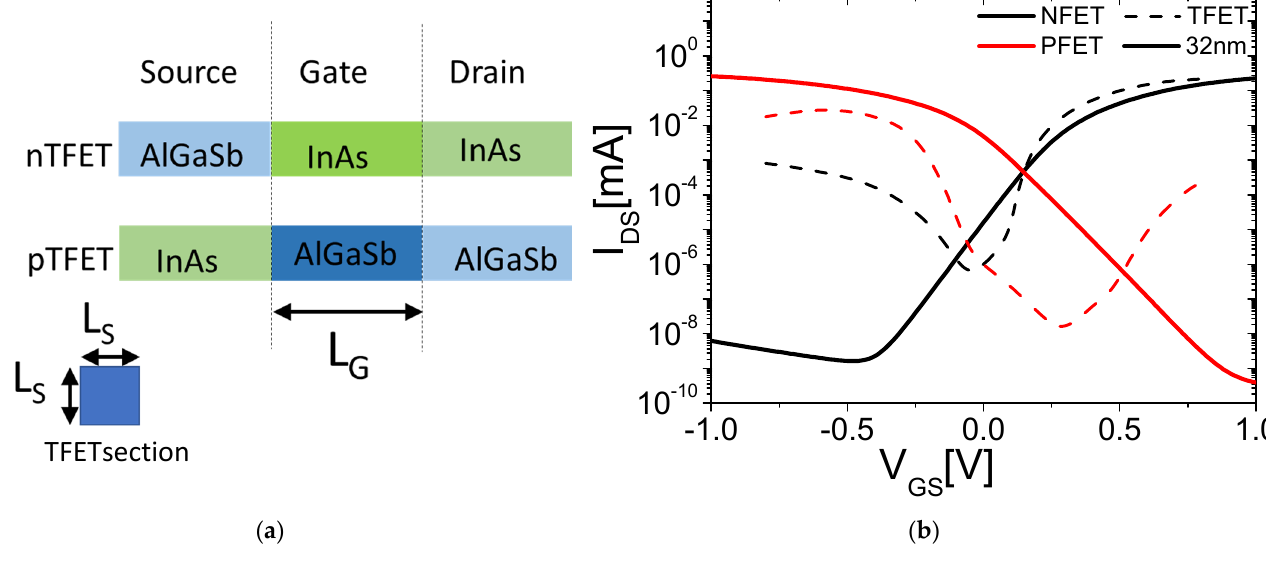
Figure 2. ( a ) Nanowire (NW) structure of the considered TFET. The NW section is a square of side L S =7 nm. The gate length is L G = 20 nm, and the gate dielectric consists of 2.3 nm of Al2O 3 all around the gate portion, which results in aa EOT = 1 nm; not shown. ( b ) The simulation of I-V characteristics of the 32 nm MOSFET and the Tunnel-FET for p- and n-FET.